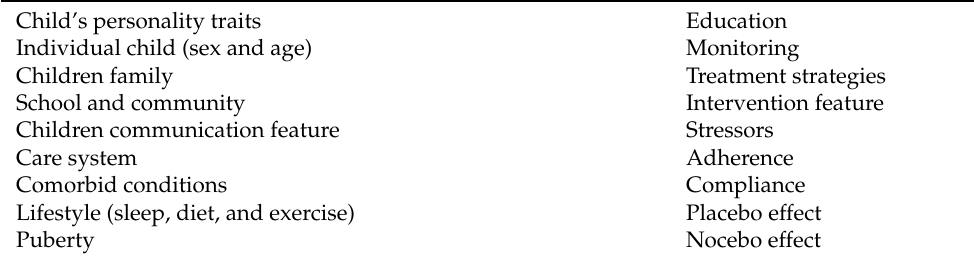
Table 2. Factors affecting mood and migraine relationship in